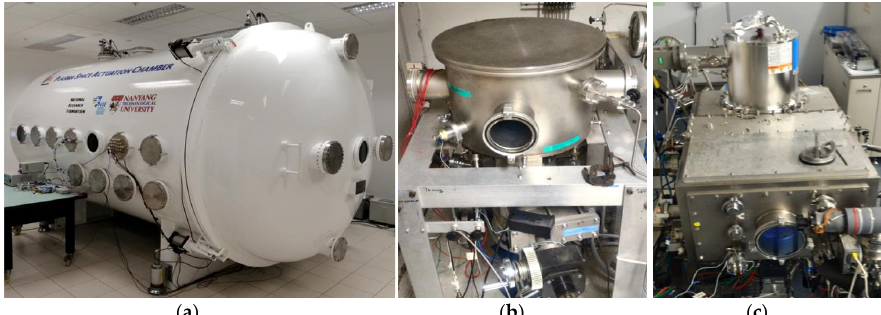
Figure 2. Vacuum facilities at the Plasma Sources and Applications Centre/Space Propulsion Centre Singapore (PSAC/PSC): ( a ) Space Environment Simulation Chamber; ( b ) Cathode Experiments Vacuum Chamber (CEVAC); ( c ) Thruster Experiments Vacuum Chamber (TEVAC).